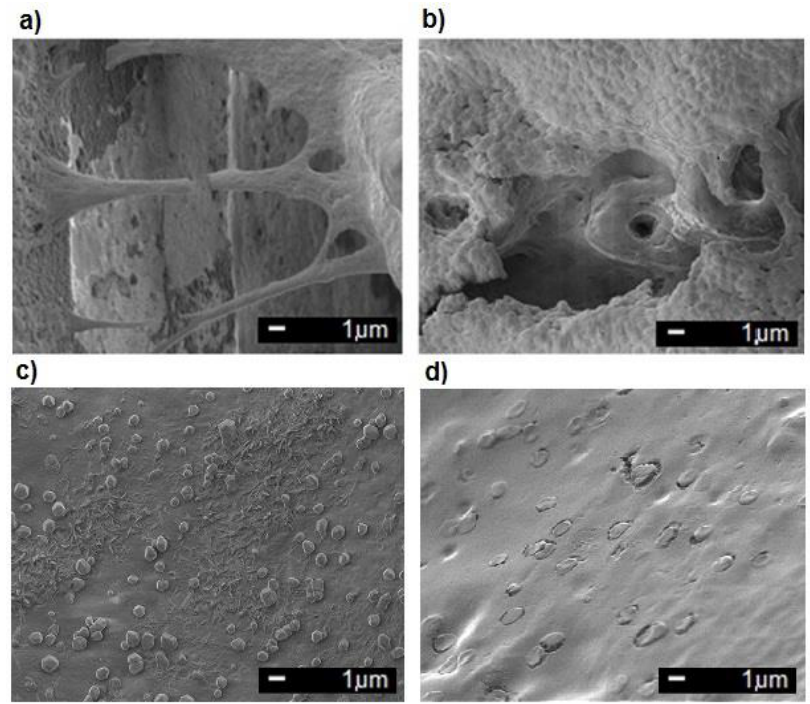
Figure 4. Organic remains on the surfaces of used dental implants: ( a ) A company; ( b ) B company; ( c ) C company; ( d ) D company. SEM.